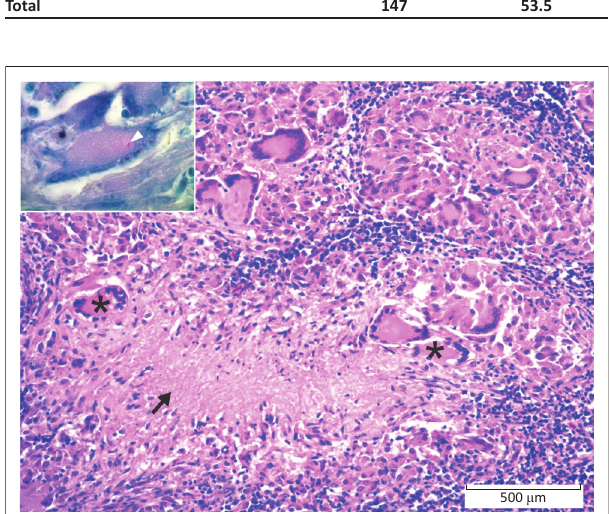
FIGURE 3: Lymph node, African buffalo. Granuloma with multinucleated giant cells ( * ) and central necrosis (arrow). Haematoxylin and eosin. Inset : A rare intracytoplasmic acid-fast (Ziehl-Neelsen) bacillus (arrowhead) is present within a giant cell. Ziehl Neelsen.